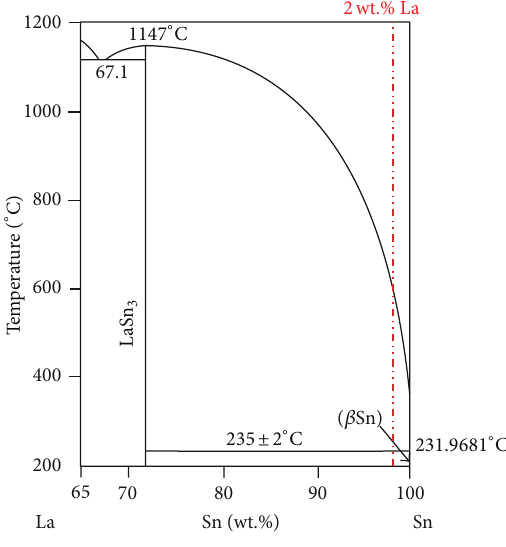
Figure 10: Binary La-Sn diagram